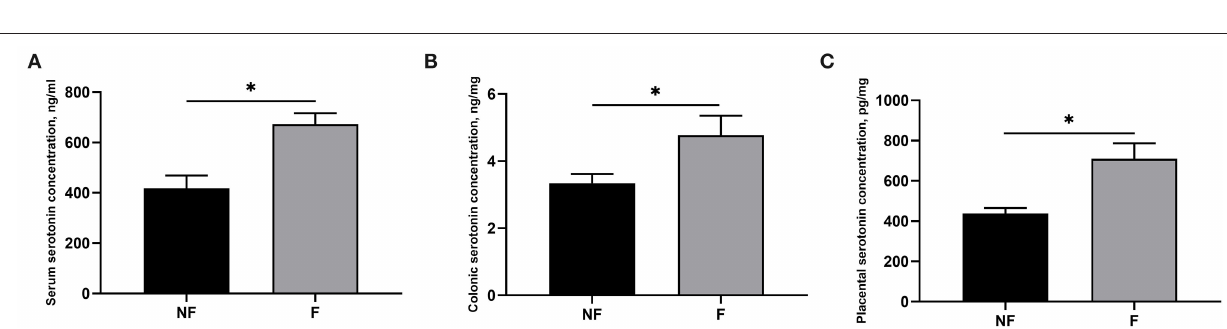
were no significant differences in the mRNA expressions of